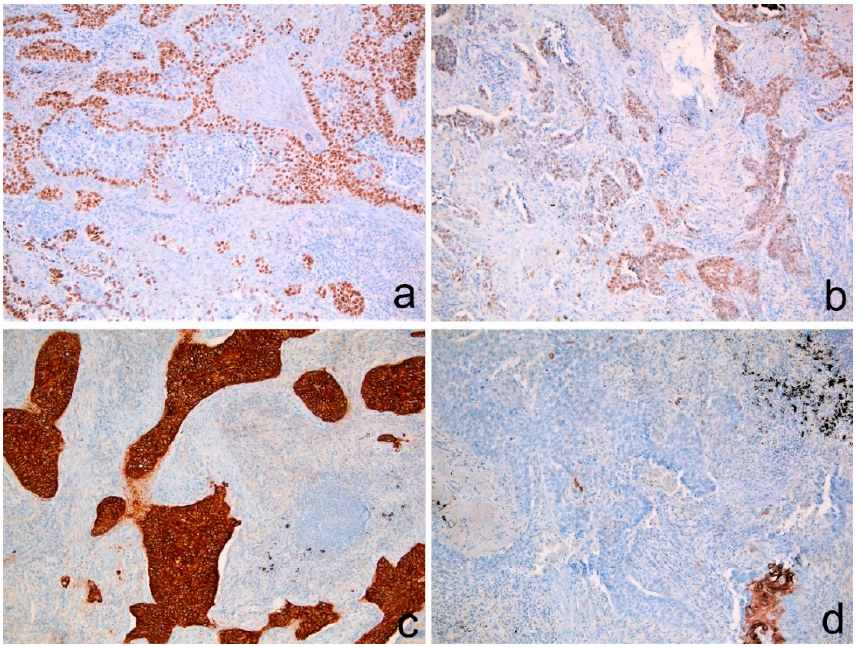
Figure 3. Positive immunostaining for ( a ) p63, ( b ) TTF-1 and ( c ) CK5/6 in neoplastic infiltrating areas. ( d ) CK7 was absent in most areas. ( a – d ) Immunoperoxidase stain. Original magnification: ( a – d ) 100×.